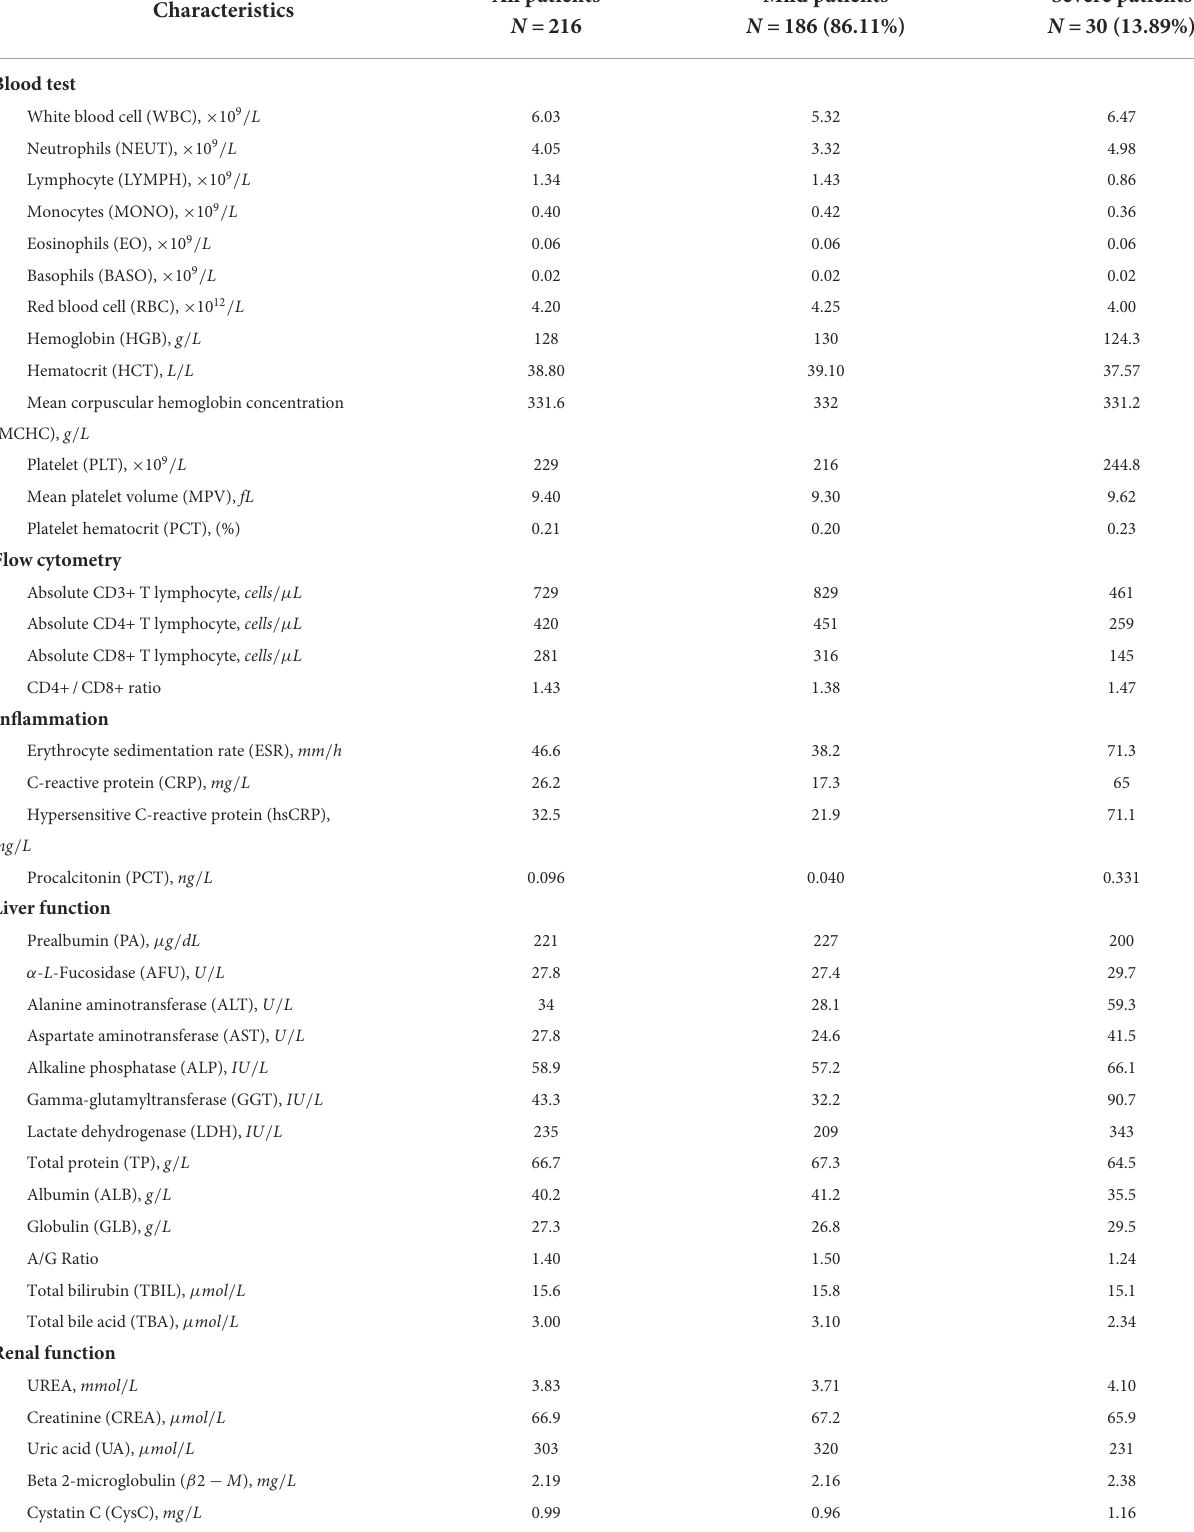
TABLE 1 Characteristics of multimodal lab test results of the COVID-19 patients contained in the dataset. All patients Mild patients Severe patients Characteristics N =216 N =186 (86.11%) N =30